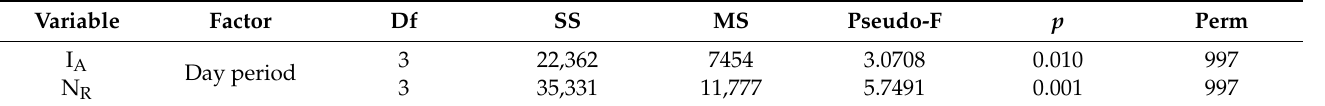
Table 2. Results of univariate PERMANOVAs main tests regarding the daily variation of the dusky groupers activity index (I A ) and the number of receivers with detections per hour (N R ) in the Pessegueiro island and Martinhal Islets study areas.